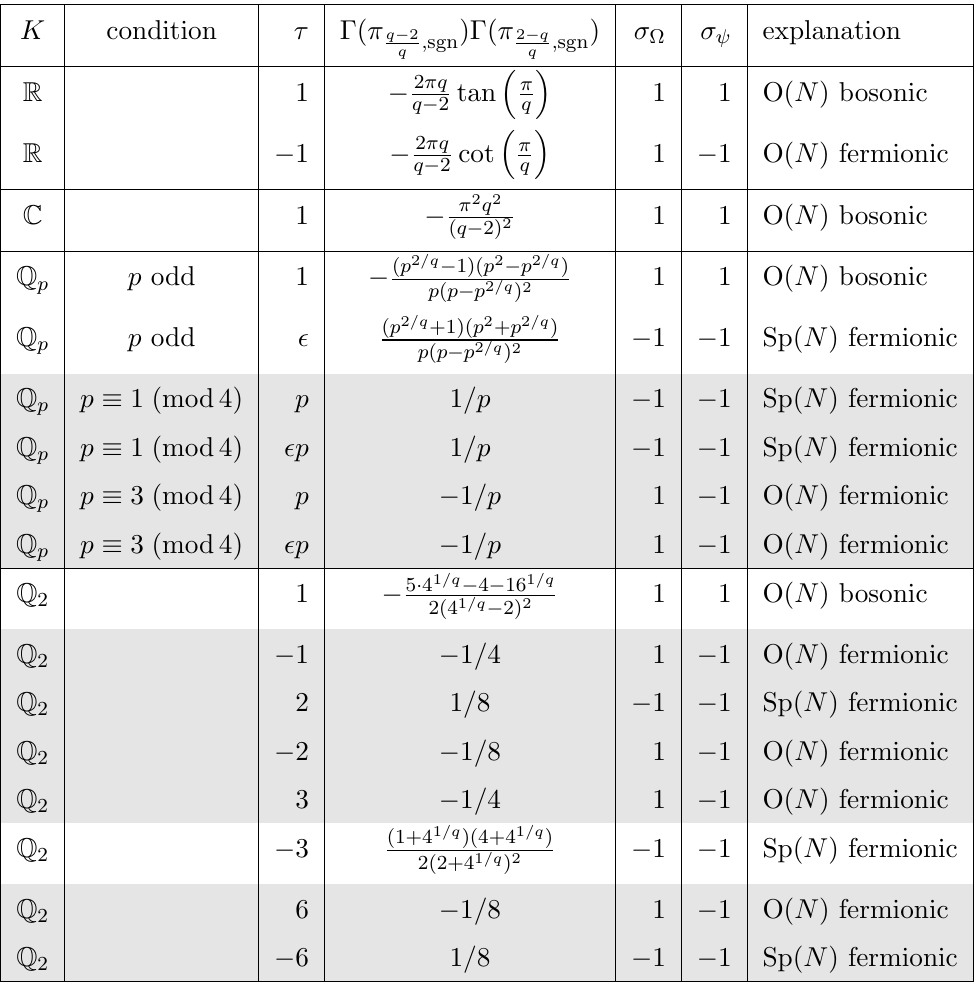
Table 2. Table of melonic theories, Archimedean or ultrametric. Shaded rows indicate theories for which an exact solution to the Schwinger-Dyson equation is given in subsection 6.3. It was shown in [20] for q = 4 that the Schwinger-Dyson equation (6.6) can be solved exactly for p -adic theories when the sign function is direction-dependent, that is, when the sign function sgn( x ) depends not only on the norm j x j but also on the (cid:12)rst p -adic digit c